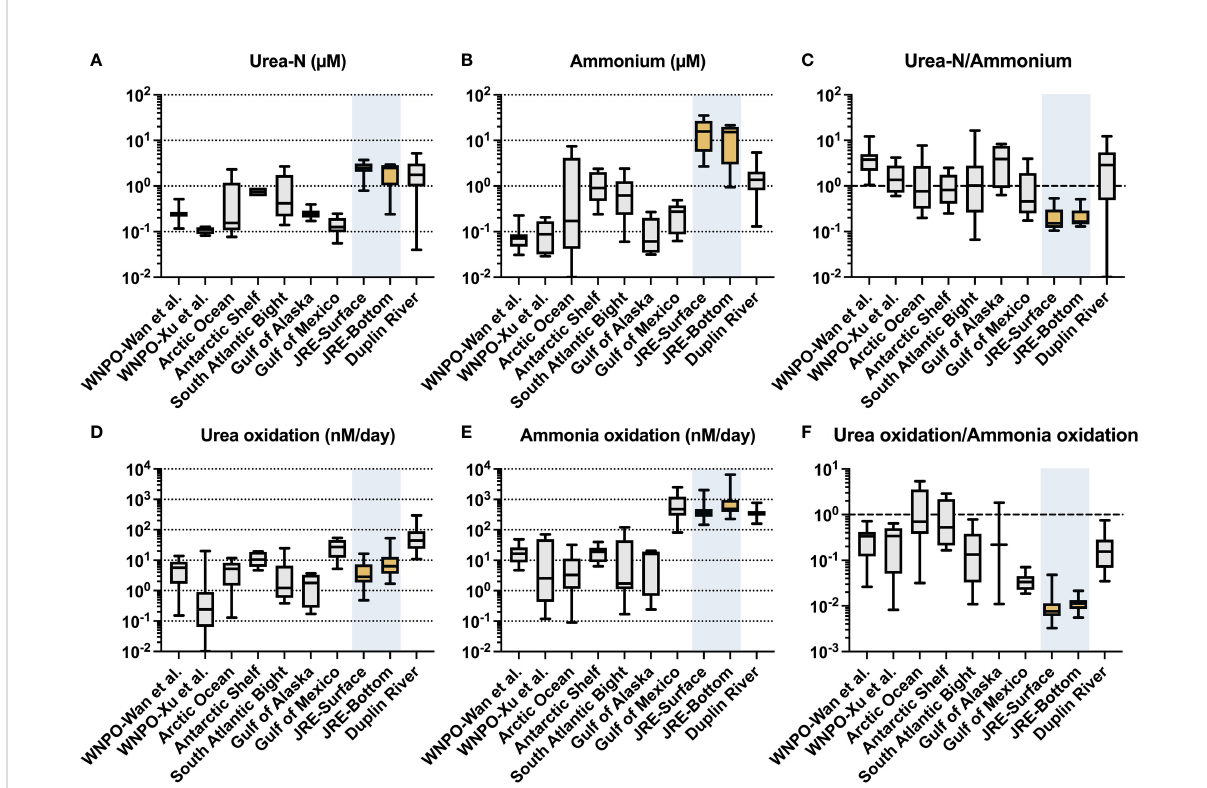
FIGURE 6 Urea-N concentration ( m M), ammonium concentration ( m M), ratio of urea-N to ammonium concentration; urea oxidation rates (nM/day), ammonia oxidation rates (nM/day), and urea oxidation to ammonia oxidation rates ratios collected from different literature: western North Paci fi c Ocean (WNPO) data was obtained from Wan et al. (2021) and Xu et al. (2019); Arctic Ocean data was obtained from Shiozaki et al. (2021); Antarctic Shelf, South Atlantic Bight, and Duplin River data were obtained from Tolar et al. (2017); Gulf of Mexico data was obtained from Kitzinger et al. (2019); Jiulong River Estuary (JRE) data was obtained from this